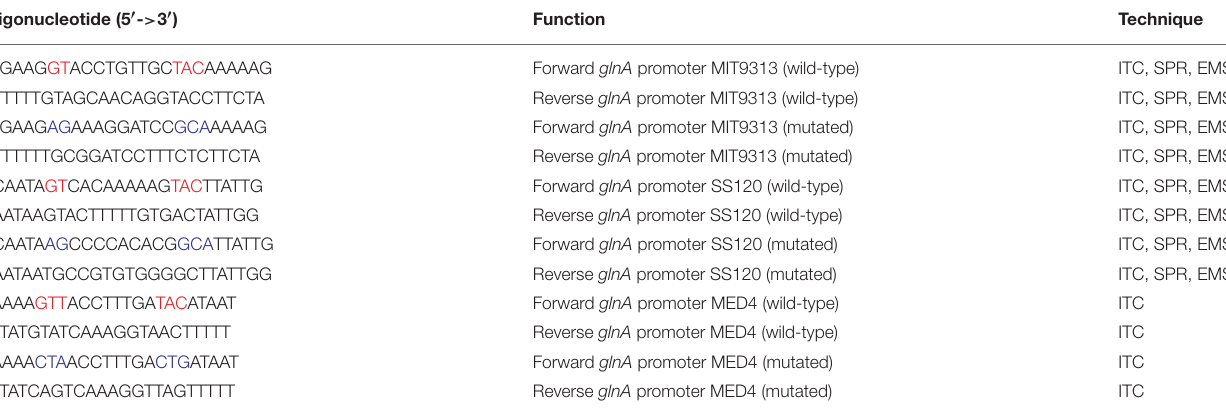
TABLE 1 | Wild-type and mutated oligonucleotides corresponding to the promoter of the glnA gene in Prochlorococcus sp. strains MIT9313, SS120, and MED4. Oligonucleotide (5 ′ - > 3 ′